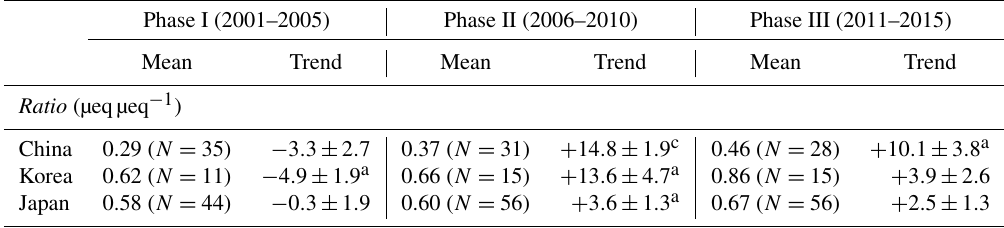
Table 3. Statistical analysis of average values and linear trends for NO − over China, Korea, and Japan during phases I, II, and